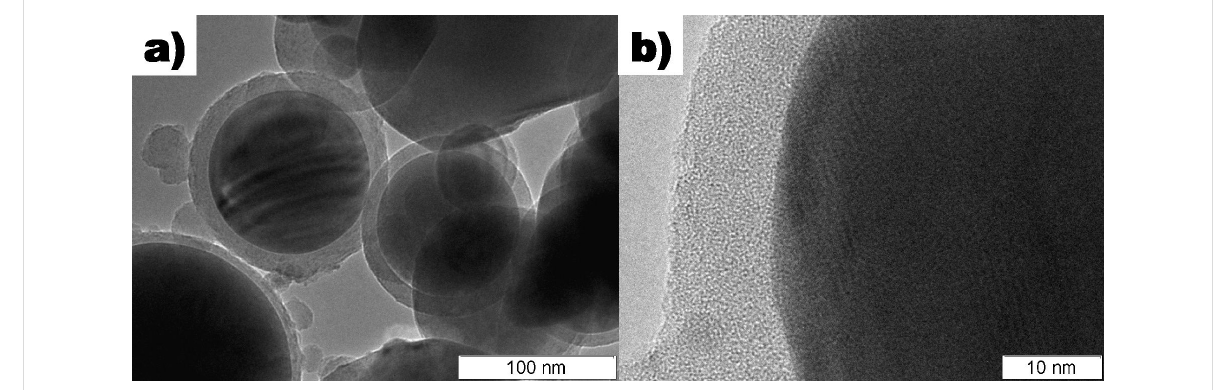
Figure 1: TEM micrograph of the Cu@silica nanoparticles. a) Overview, b) detail of the core and shell structure.